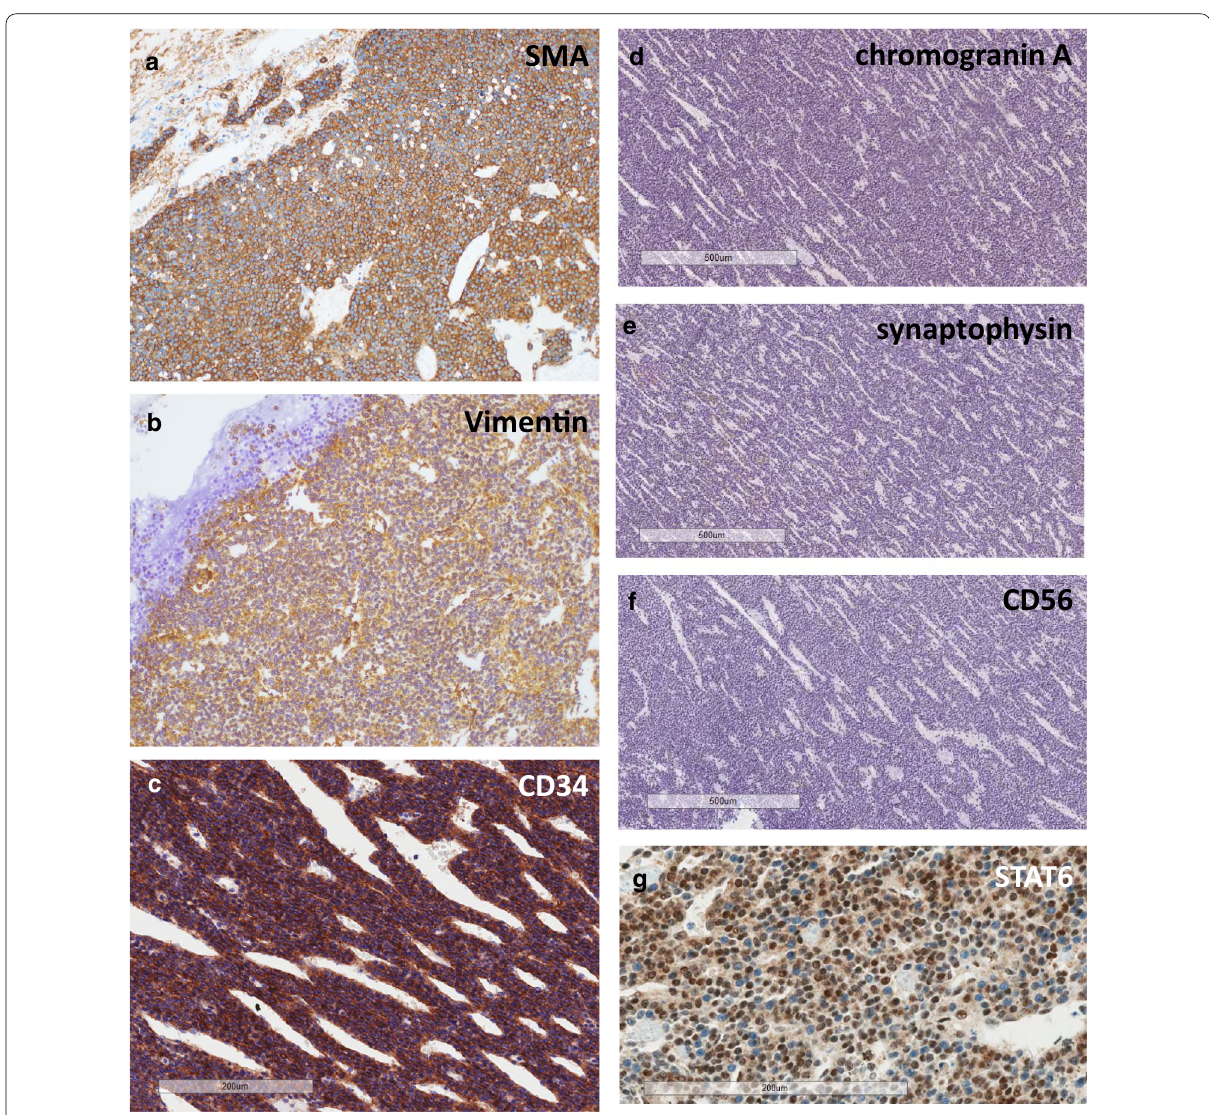
Fig. 6 Immunohistochemistry. Immunohistochemistry demonstrates positive reactivity for smooth muscle actin ( a ), vimentin ( b ), and CD34 ( c ). Chromogranin A ( d ), synaptophysin ( e ), CD56 ( f ), and STAT6 ( g ) show negative reactivity,